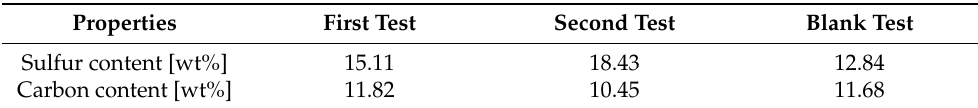
Table 7. Distribution of elements in the catalyst after deactivation by SEM.